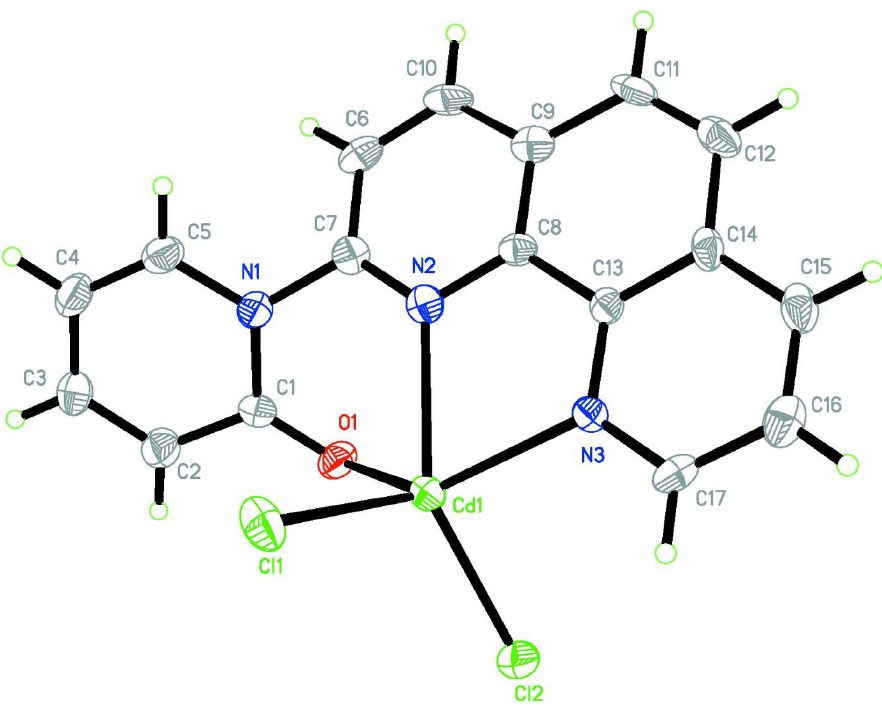
The molecular structure of the title complex showing the atom-numbering scheme and 30% probability displacement